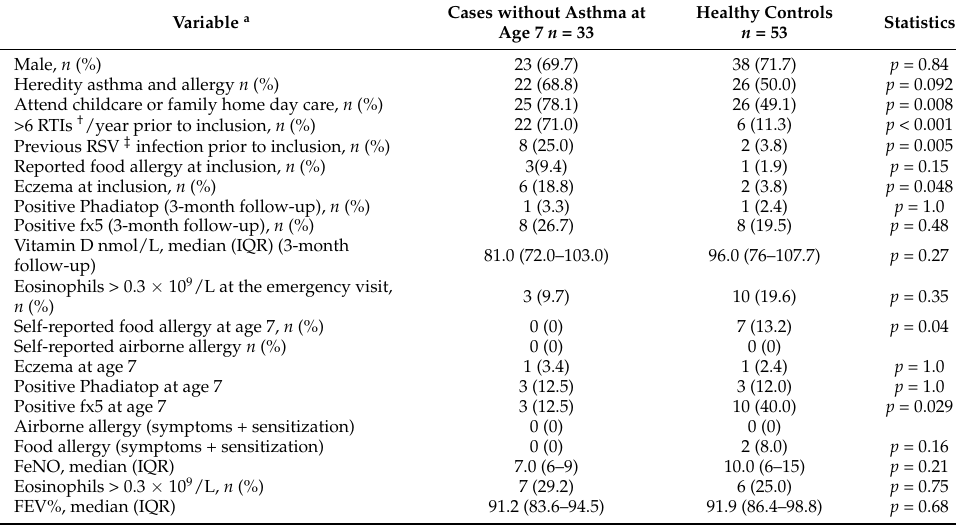
Table 3. Cases without asthma vs. healthy controls at age 7